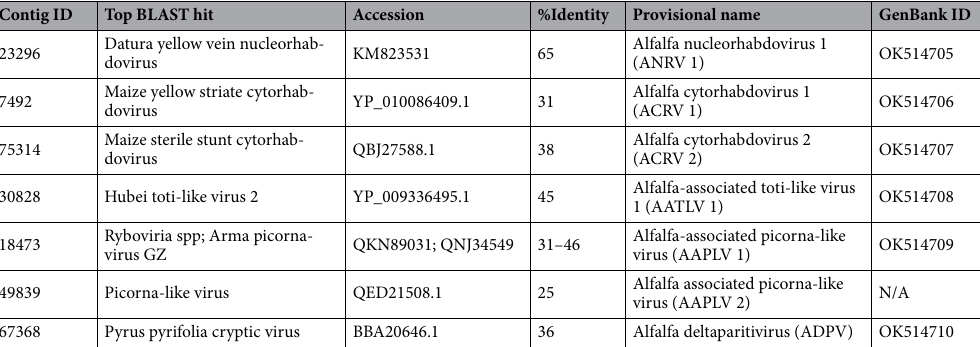
Table 2. Putative novel viruses identified in alfalfa samples collected from production fields in the U.S. Pacific Northwest in